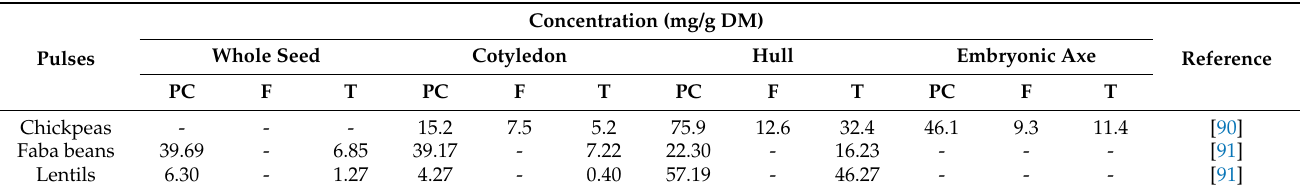
Table 2. Concentration (mg/g DM) of phenolic compounds, flavonoids and tannins in different seed parts of pulses (chickpeas, faba beans and